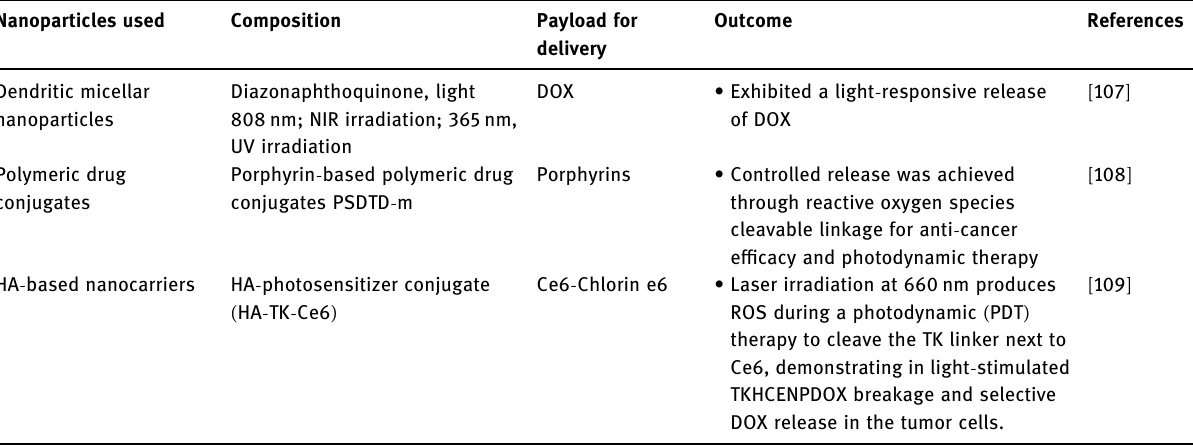
Table 7: Light responsive DDS for mono and combination cancer therapy Nanoparticles